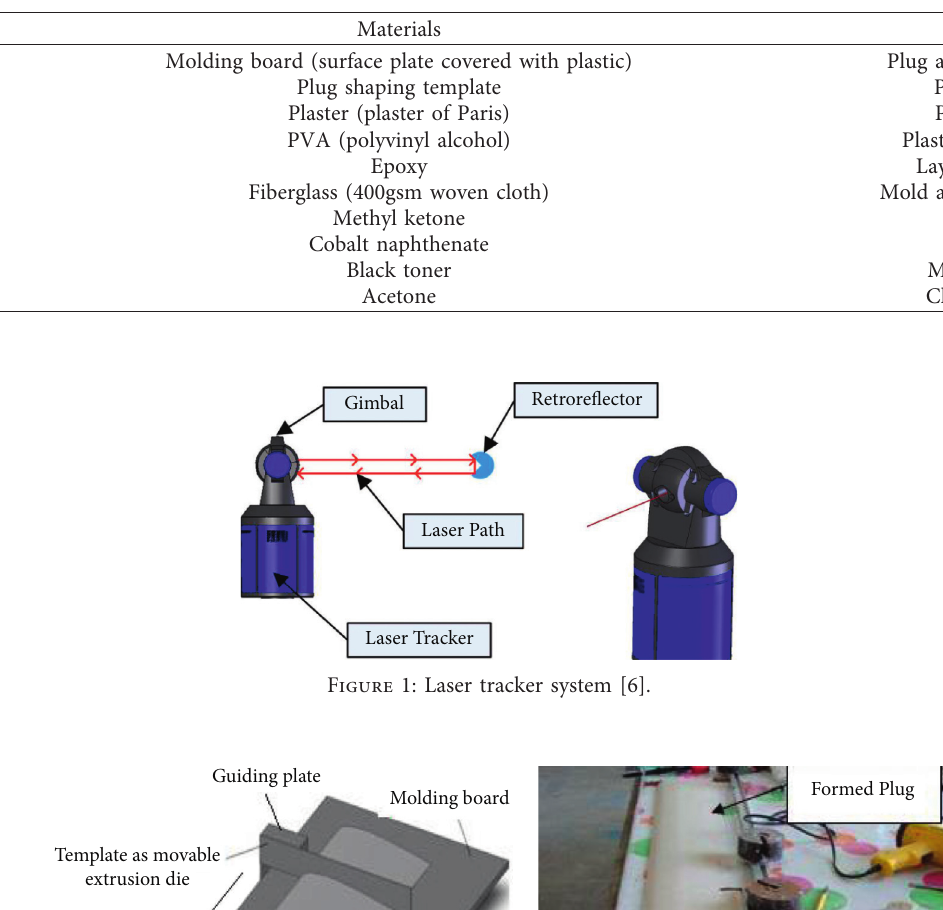
Table 1: List of materials and their purpose.